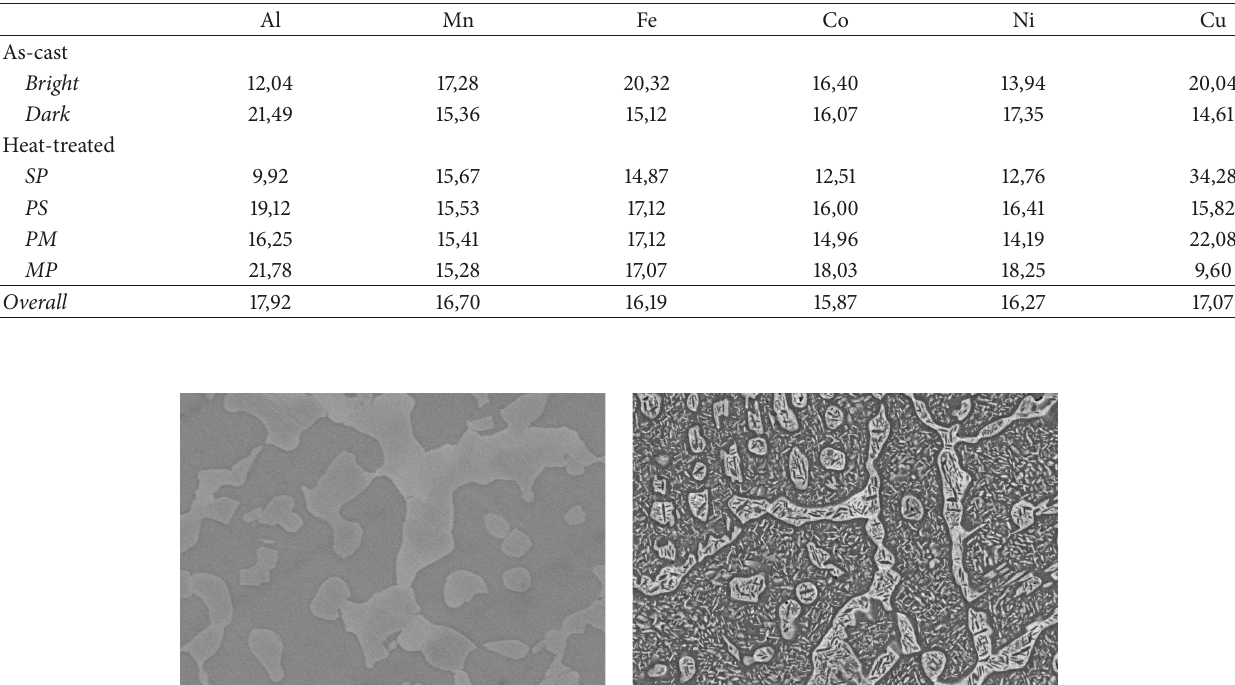
Table 2: Chemical composition of the as-cast and heat-treated alloys.